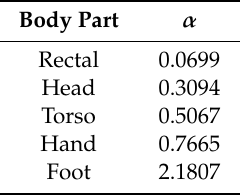
Table 4. Adjustment parameters for the core temperature in each body part [40].